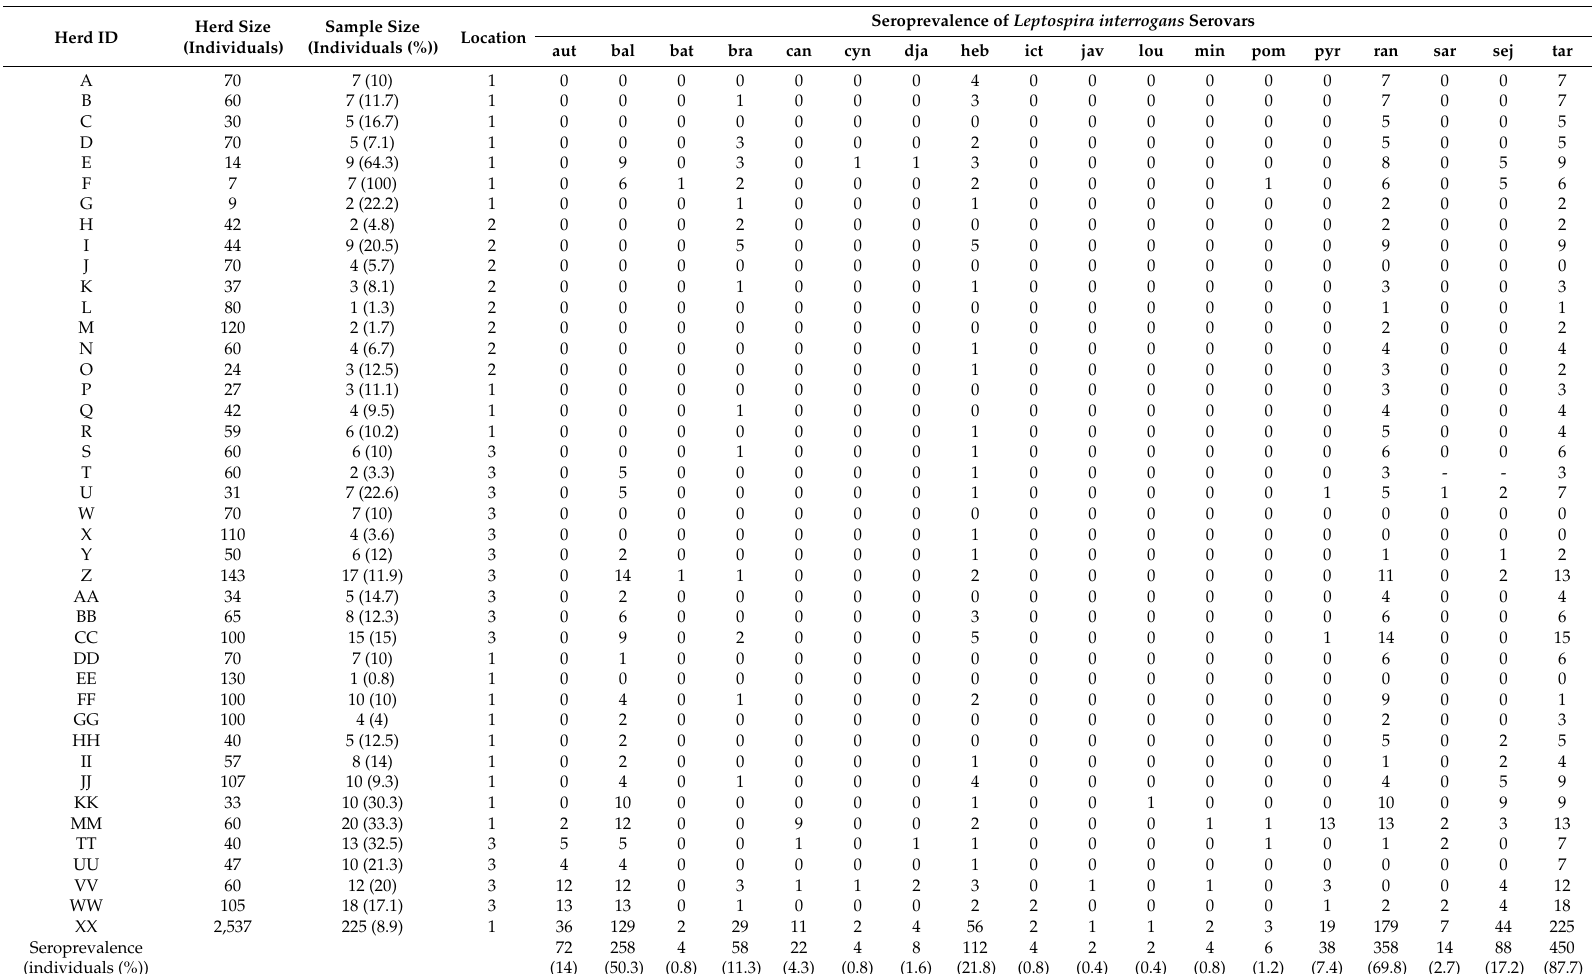
Table 1. Herd size, sample size, location and seroprevalence of Leptospira interrogans found in domestic cattle in Salakphra Wildlife